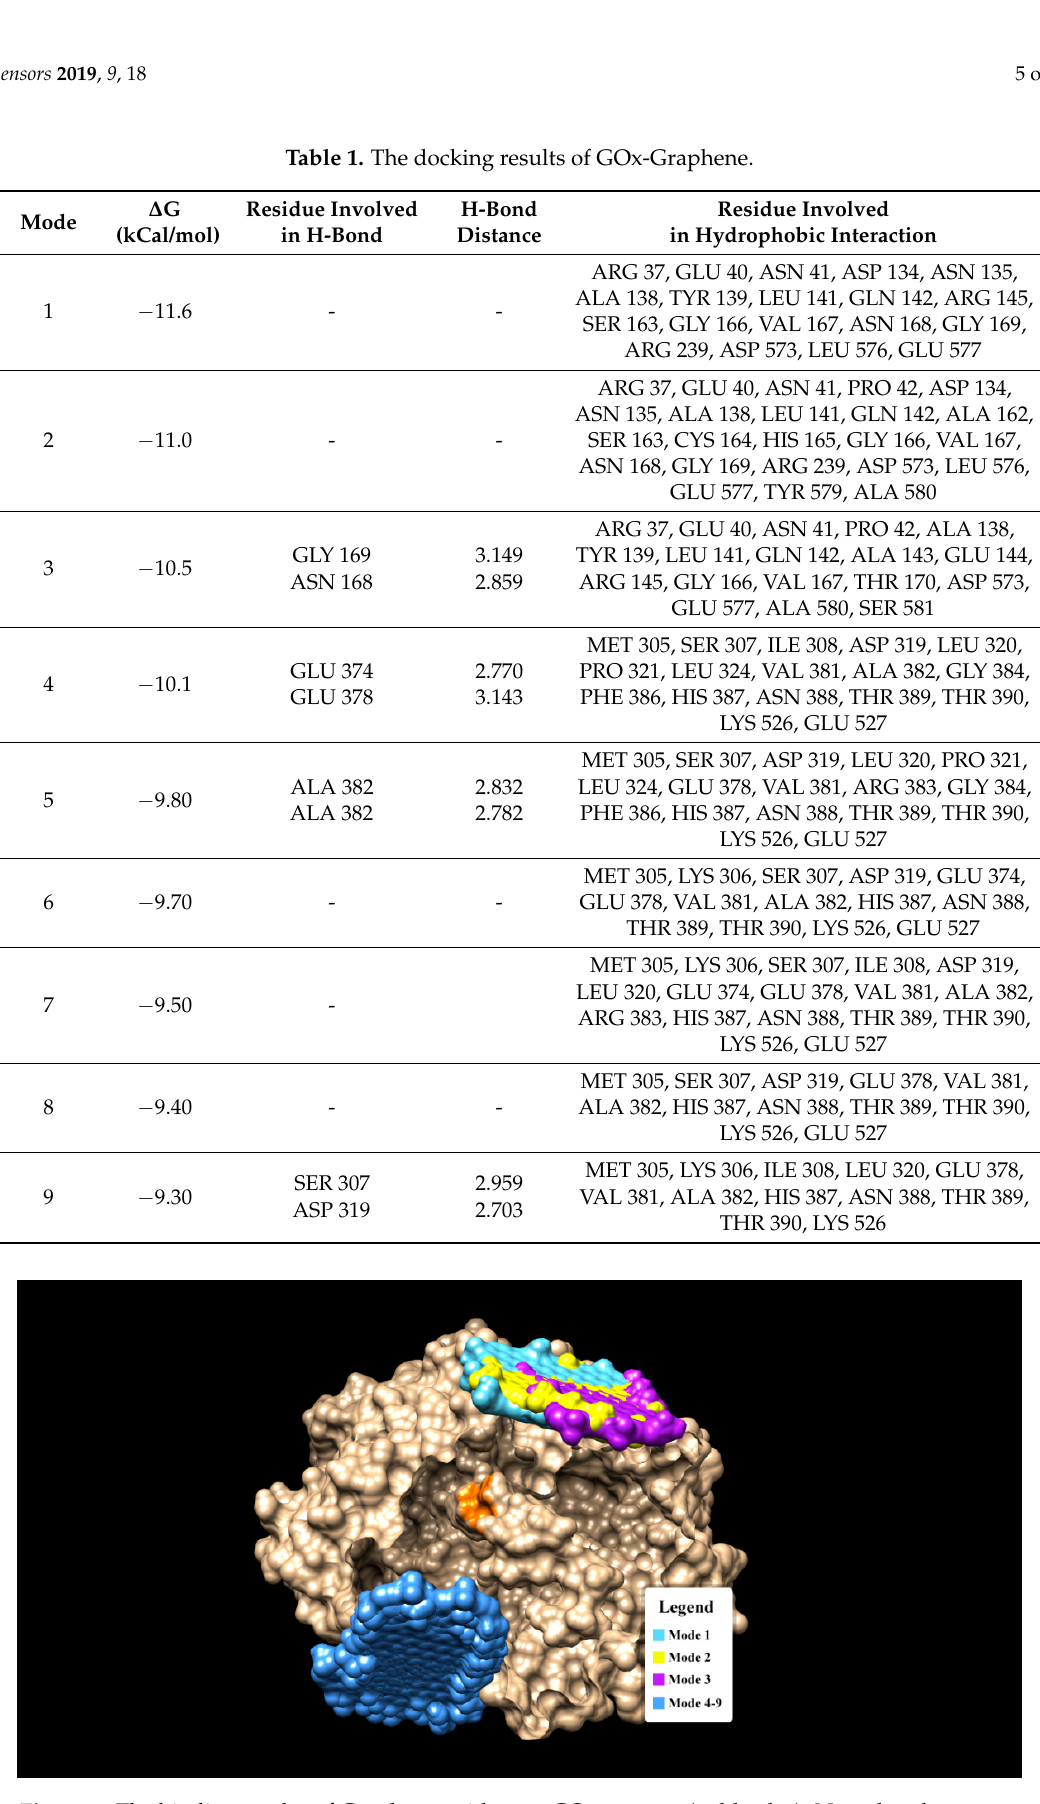
Figure 3. The binding modes of Graphene oxide on a GOx enzyme (gold color). Note that the orange spot (region) in the center of GOx indicates the active sites (interaction pocket) of β -D glucose.